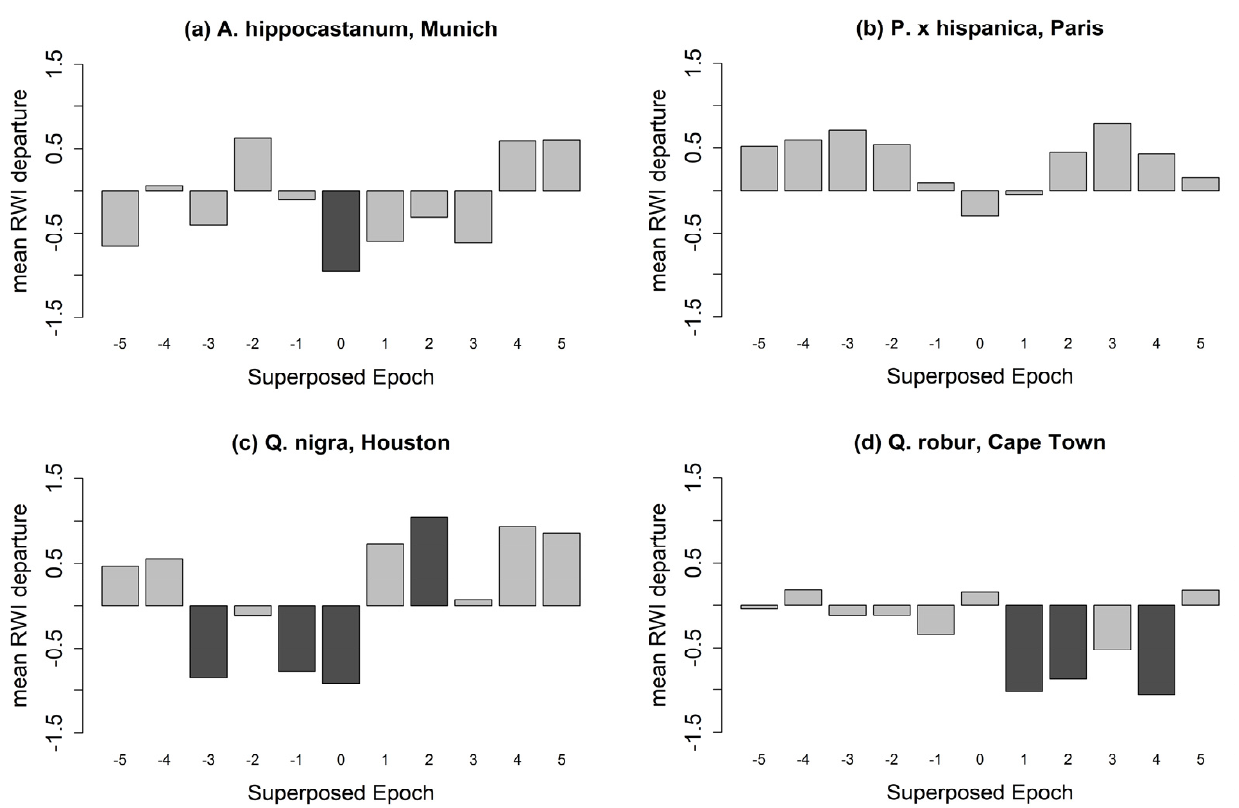
Figure 6. Superposed epoch analysis (SEA) on the influence of drought years on the ring width index (RWI) of A. hippocastanum in Munich ( a ), P. × hispanica in Paris ( b ), Q. nigra in Houston ( c ), and Q. robur in Cape Town ( d ). RWI is shown for the drought years (0), the pre-drought ( − 5 to − 1), and post-drought years (1 to 5). Input drought years for each city are shown in Table 4. Significant RWIs ( p < 0.05) are shown in dark